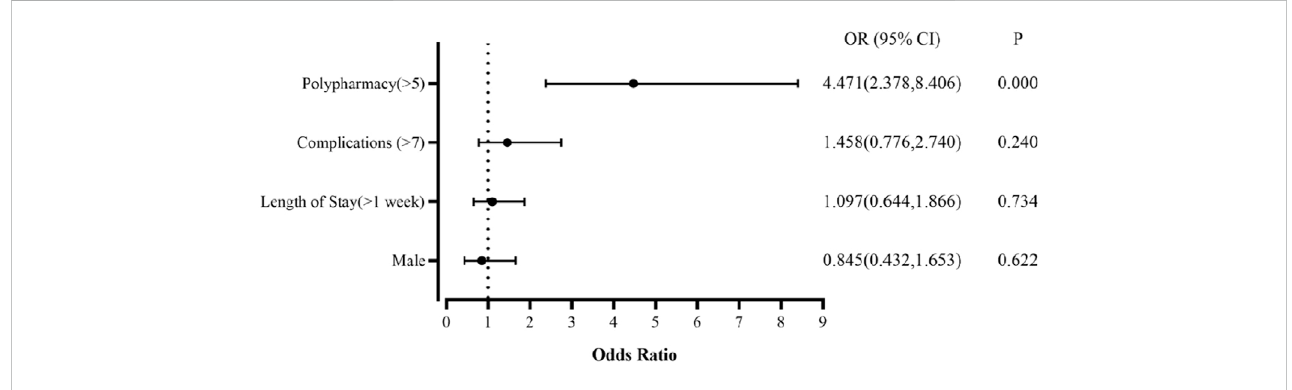
FIGURE 4 Binary logistics regression analysis of factors related to PIM.